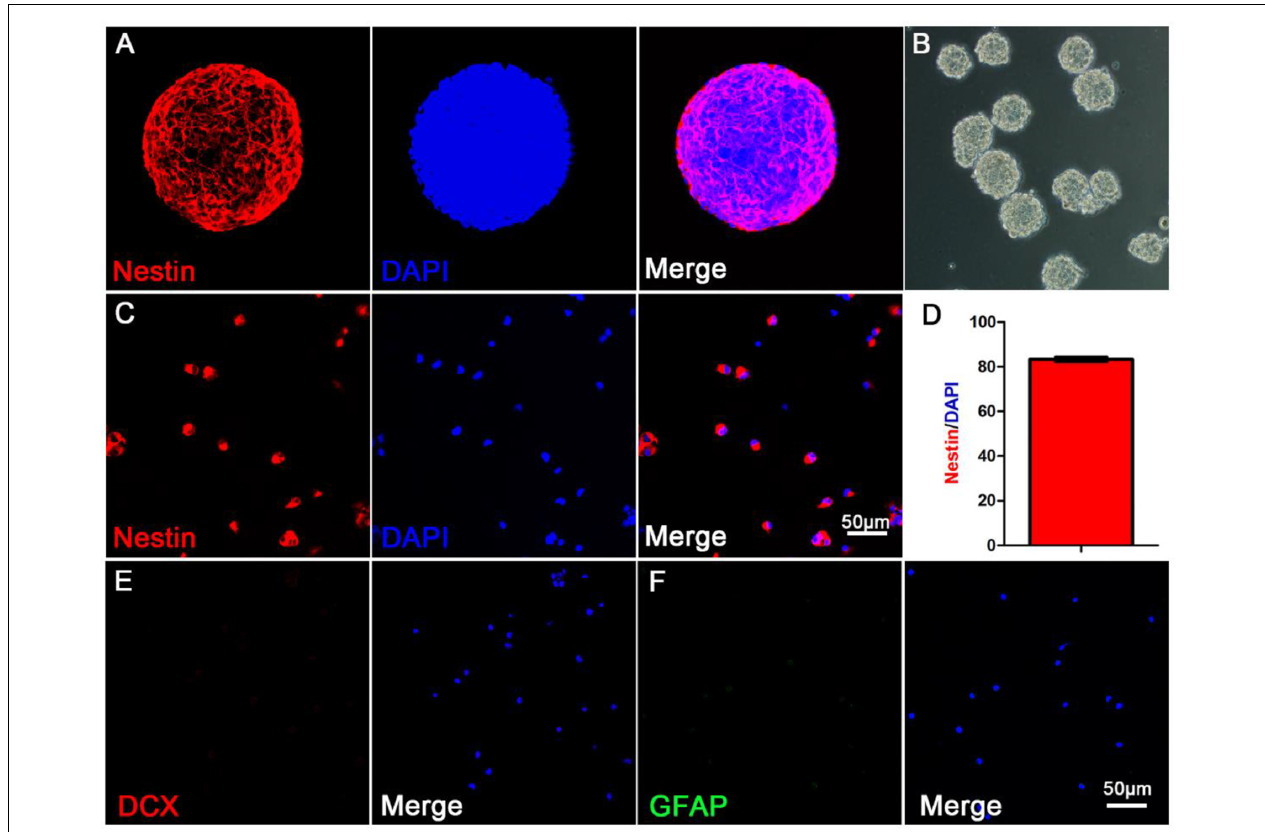
FIGURE 1 | The morphological and purity identification of primary neurospheres and neural stem cells. (A) Nestin and DAPI fluorescent staining of primary neurospheres composed of neural stem cells; (B) The morphological status of primary neurospheres in vitro ; (C) Nestin and DAPI fluorescent staining of scattered primary NSCs; (D) The purity statistics of primary NSCs; (E) DCX and DAPI staining of scattered primary NSCs; (F) GFAP and DAPI staining of scattered primary NSCs.